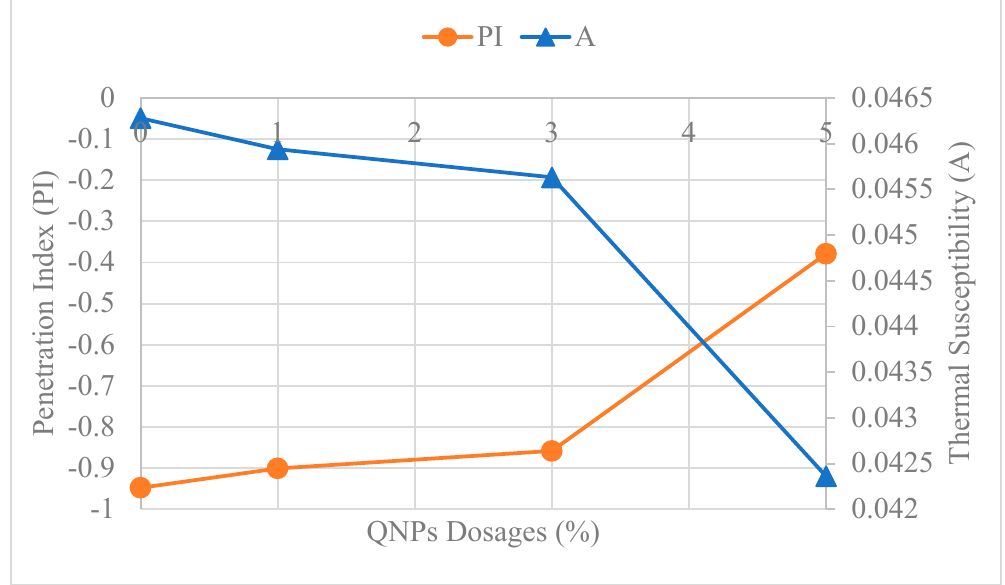
Figure 9. Influence of QNPs on penetration index and thermal susceptibility.